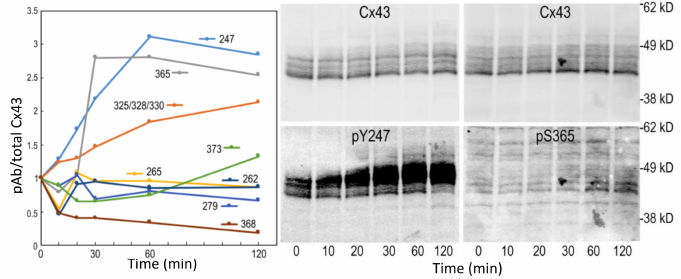
Figure 6. Time course of the change in Cx43 phosphorylation changes in response to MG132 treatment. The blots for the sites exhibiting the largest change are shown (pY247 and pS365).